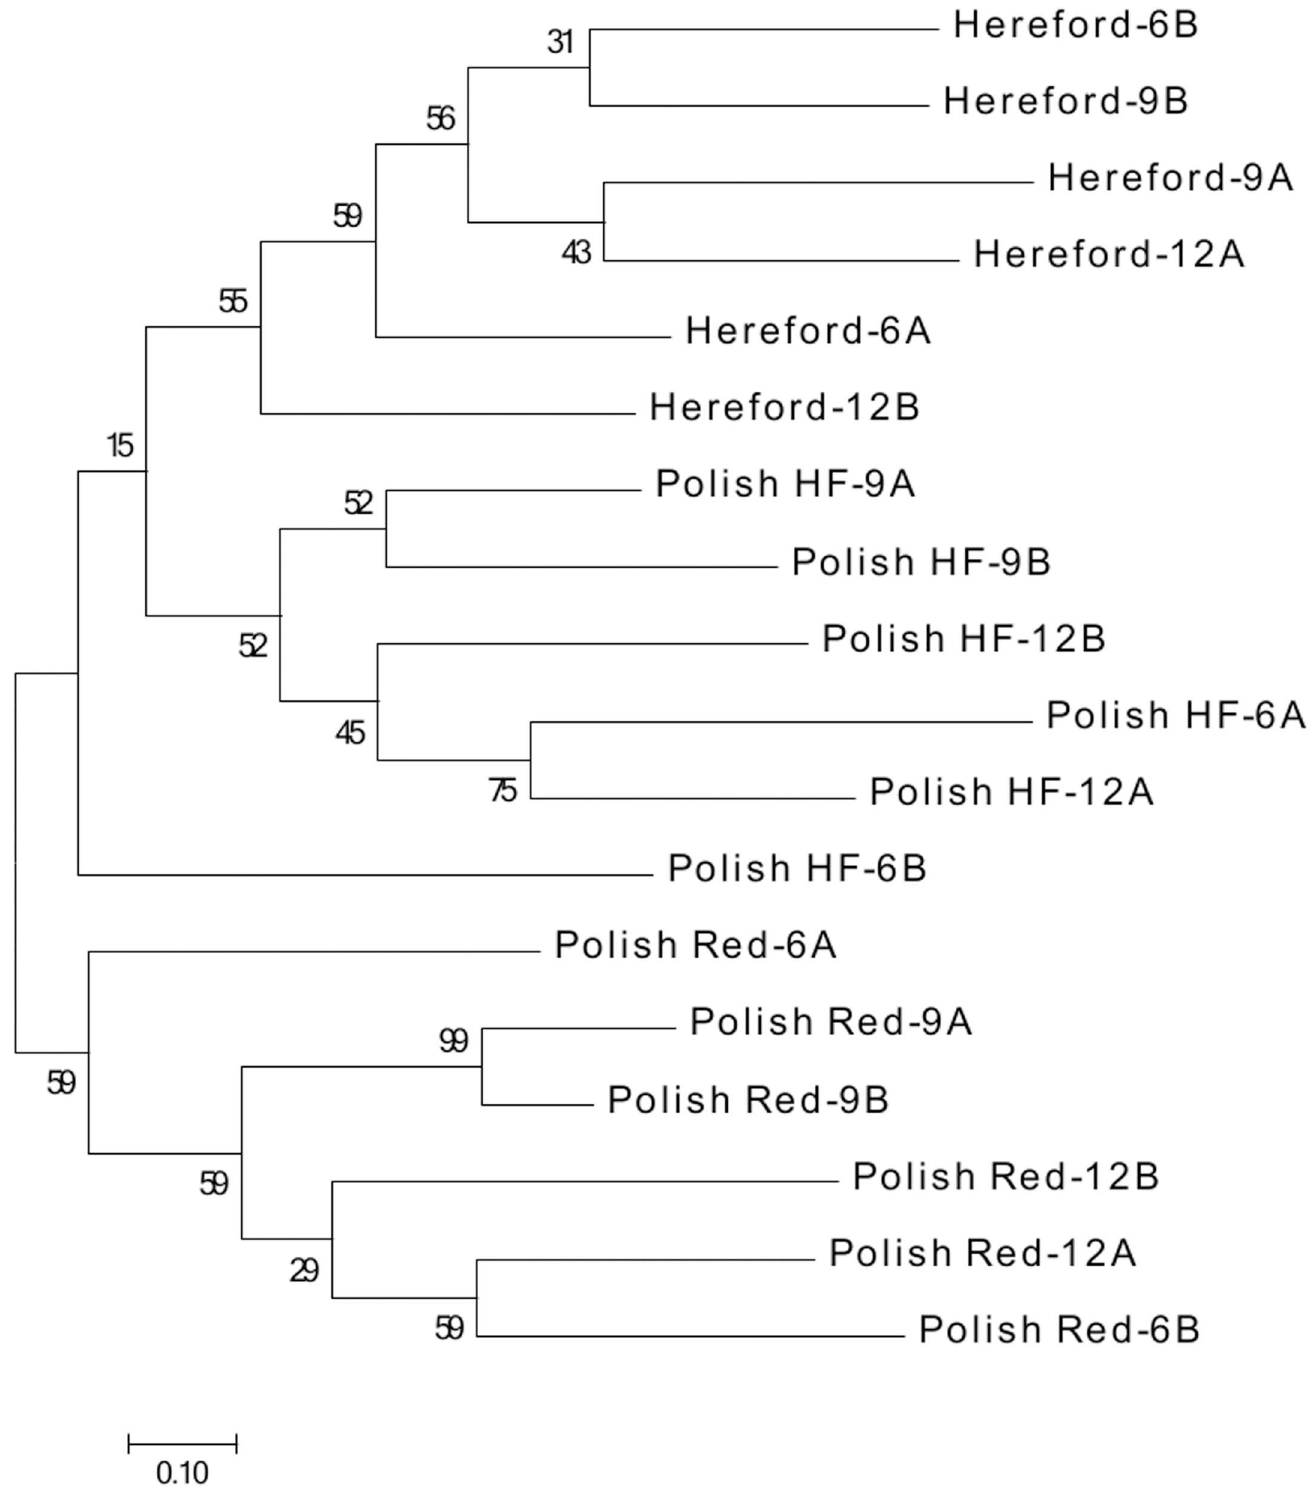
Fig 2. The phylogenetic relationship among RNA-seq samples of bovine liver using Maximum likelihood method based on the JTT matrix- based model. An unrootedphylogeny tree of 18 bulls’ samplesrepresentingdevelopmental ages 6 months (6A, 6B), 9 months (9A, 9B), and 12 months (12A, 12B) of Polish Red, Polish-HFand Herefordbreeds. The percentageof trees in which the associatedtaxa clusteredtogether is shown next to the branches. All nodes were robust at 100%bootstrap support. The scale bar denotessubstitutionsper site.